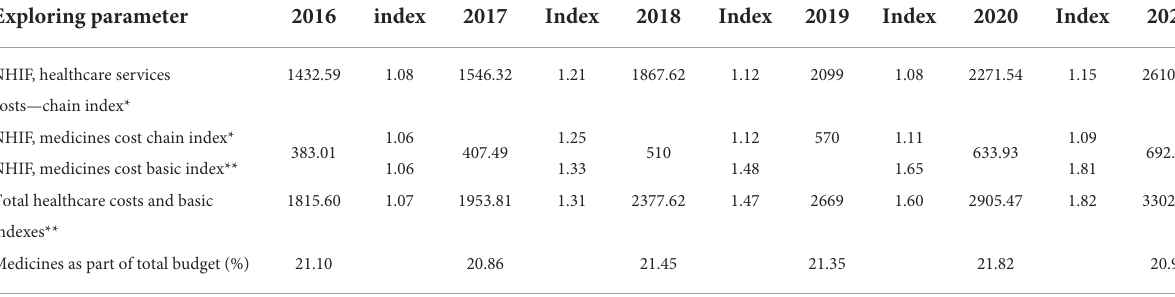
TABLE 1 Healthcare services and pharmaceuticals budget growth (mln Euro). Exploring parameter